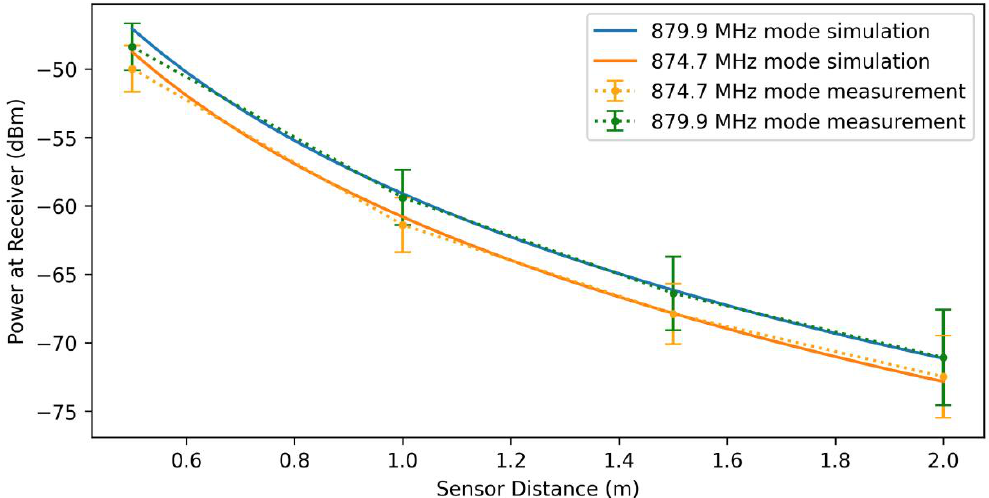
Figure 13. Signal power at receiver for a peak transmitter power of 19 dBm. The difference in measured and simulated values can be largely attributed to the impact of the directionality of the transmitter and receiver antennae at 50 cm.